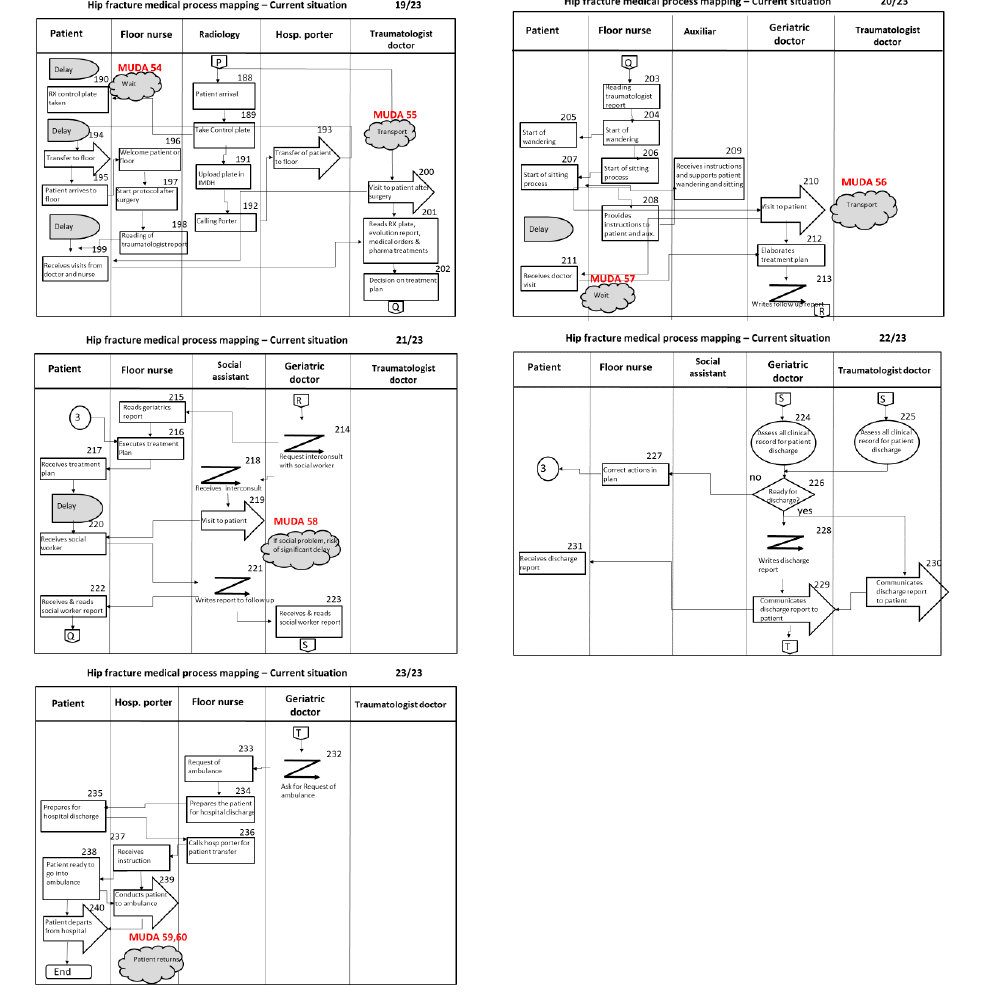
Figure A2. Hip Fracture Process Flowcharts.